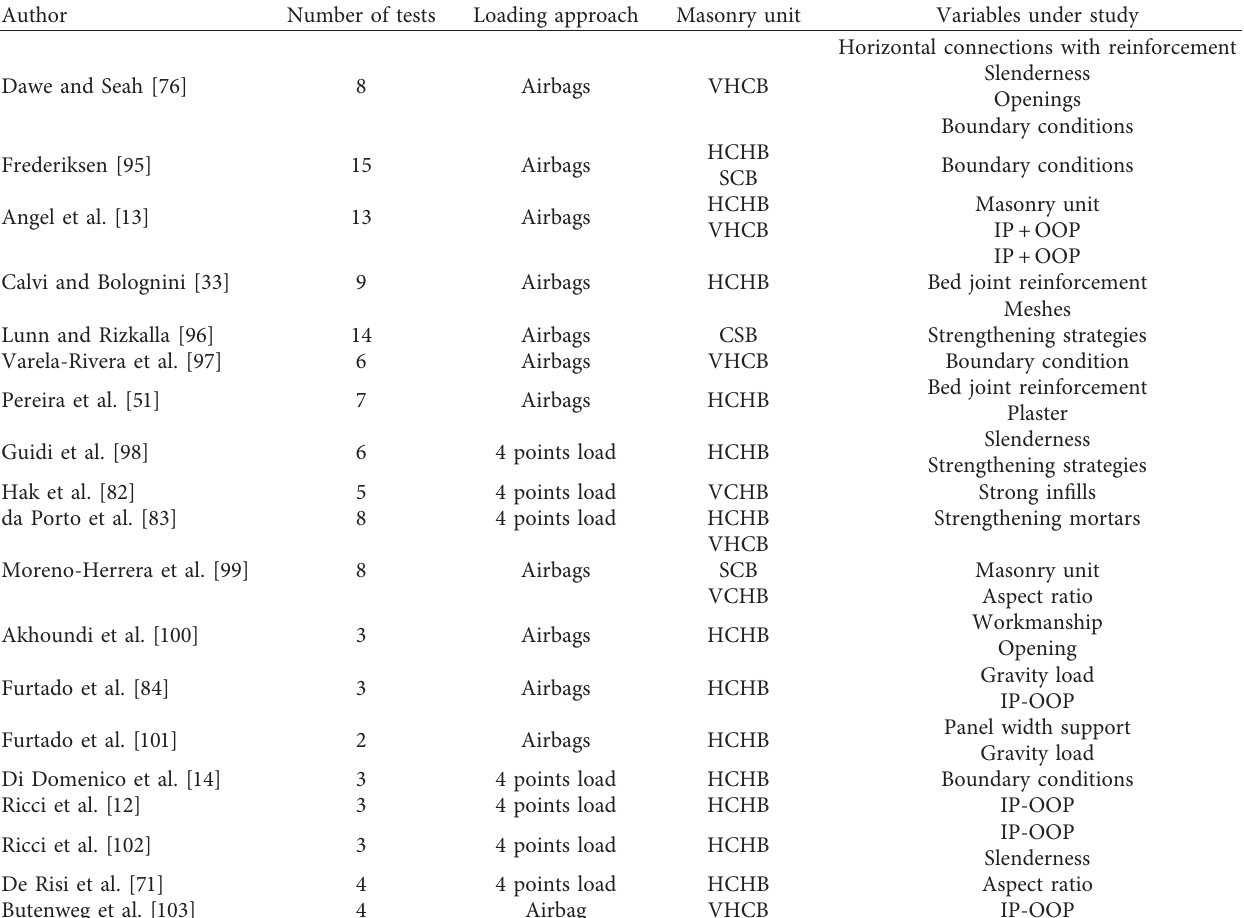
Table 2: Literature review of OOP experimental tests of masonry infill